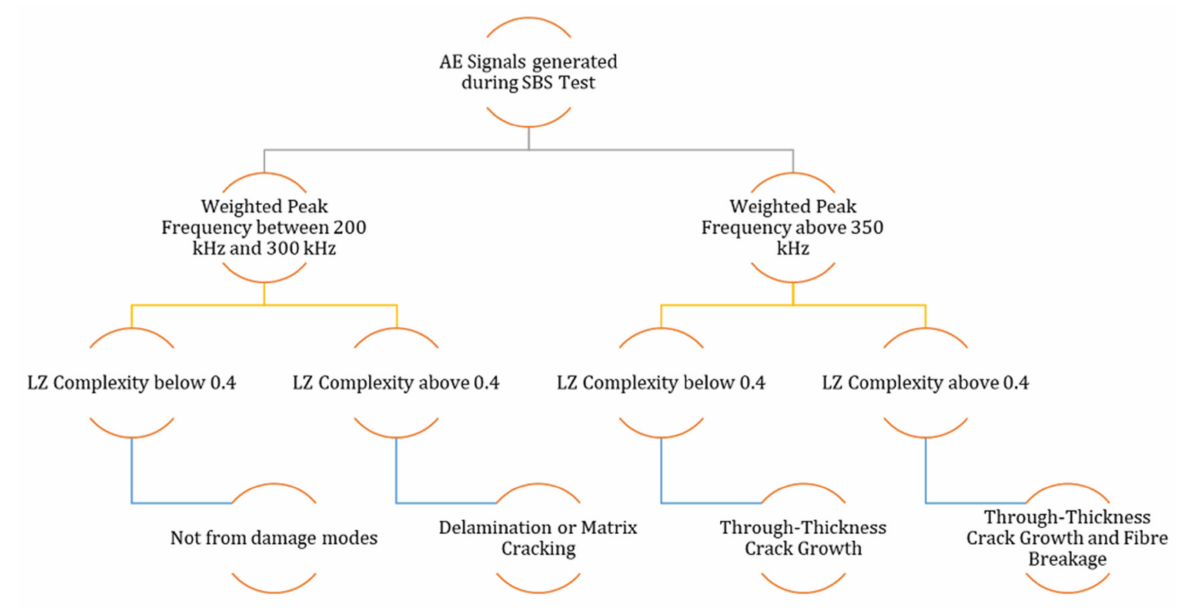
Figure 15. Classification of Damage Modes using W.P-Freq and LZ